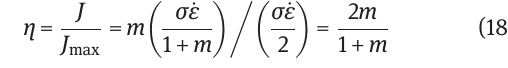
Figure 11: Comparison of the corrected curve and the results predicted by the constitutive equation: (a) _ ε = 0.1 s − 1 ; (b) T = 1,200°C.